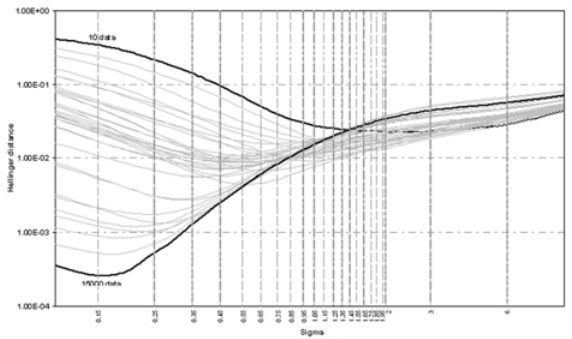
Fig. 2. Distance between the true PDF and its Parzen windows estimation with varying kernel width s. The number of data is a